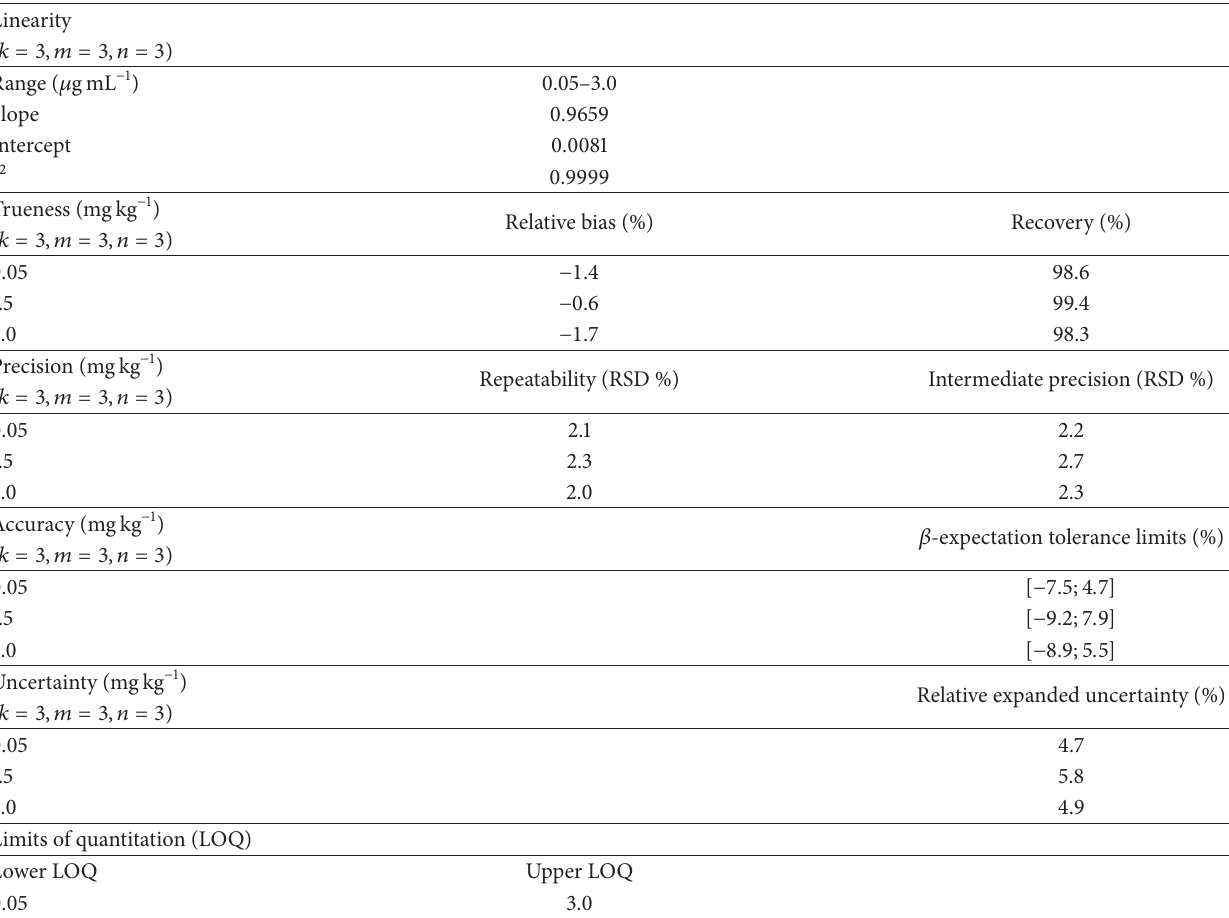
Table 1: Accuracy profile validation results for melamine in dietary